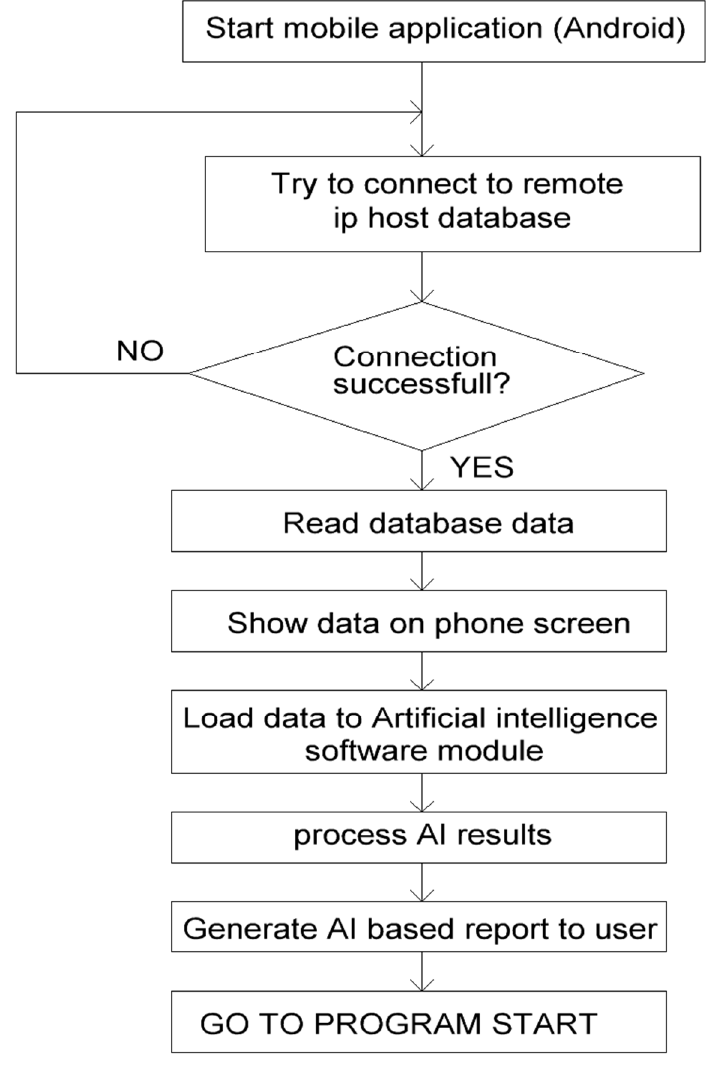
Figure 5. Schematic diagram of the algorithm of the mobile application code.